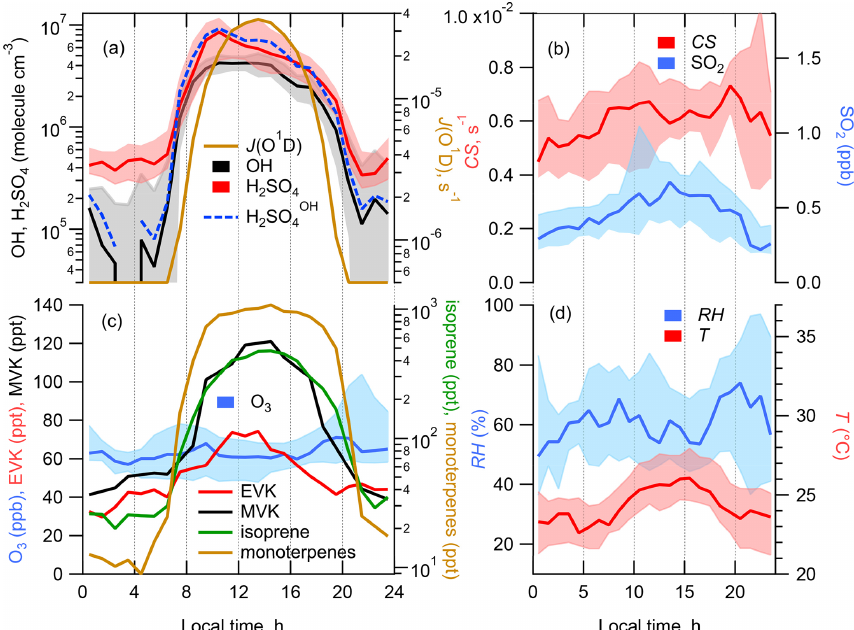
Figure 2. Median diel profiles of calculated [H 2 SO 4 ] produced in OH + SO 2 (H 2 SO OH J (O 1 D) (a) , CS and [SO 2 ] (b) , [O 3 ] and concentrations of selected VOCs (c) , and relative humidity (RH) and temperature ( T ) (d) . Shaded areas represent the 25th/75th